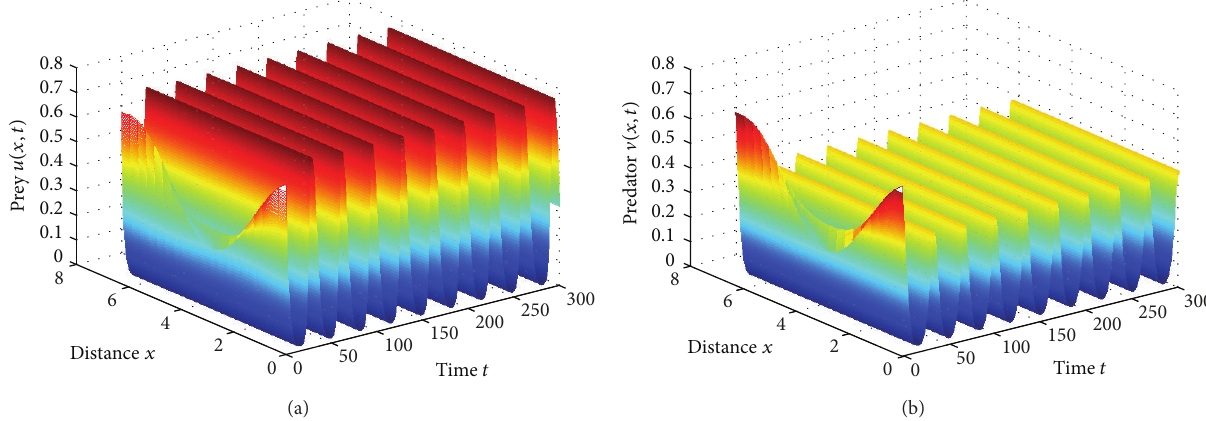
Figure 2: Spatially homogenous periodic solutions are asymptotically stable when 𝜆 = 0.24 < 𝜆 𝐻 0 and the initial function 𝑢 0 (𝑥) = 0.5 + (𝑥) = 0.5 + 0.2 cos 𝑥 0.2 cos 𝑥 , V 0